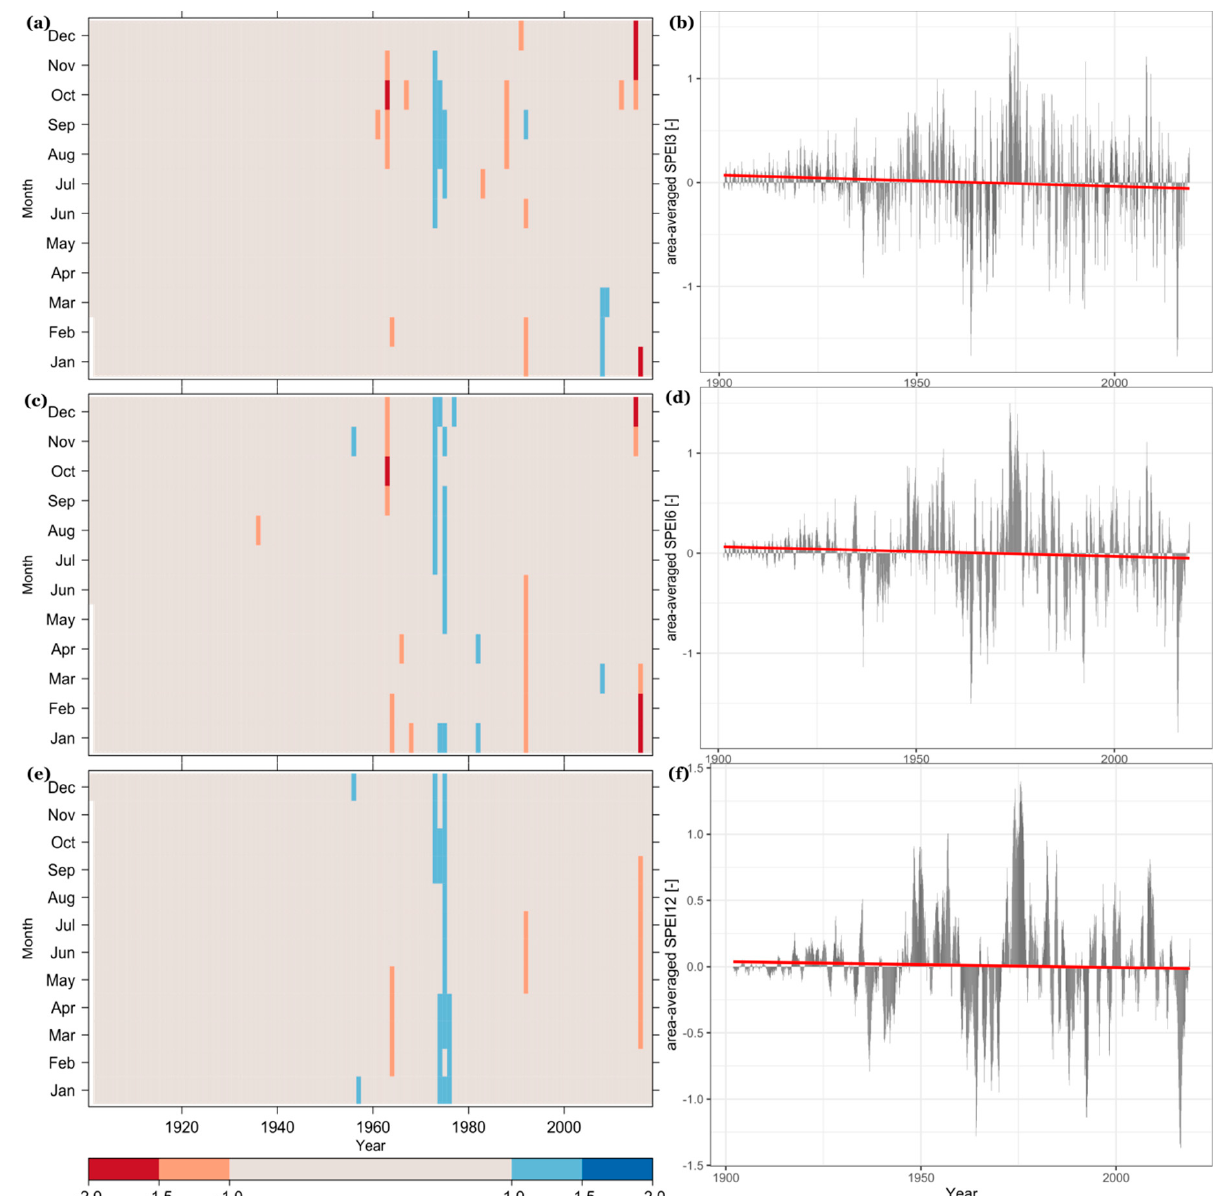
Figure 3. Long-term temporal variation of the area-averaged values of SPEI at a: ( a , b ) 3-month time scale (SPEI3); ( c , d ) 6-month time scale (SPEI6); and ( e , f ) 12-month time scale (SPEI12) in the ARB during 1901–2018. The calculation of the average is based on the median. The red line indicates the fitted line. The reference period is 1901–2018. The area-averaged values of SPEI3 ranged from − 1.672 to 1.496 with a median equal to 0.023; the area-averaged values of SPEI6 ranged from − 1.791 to 1.499 with a